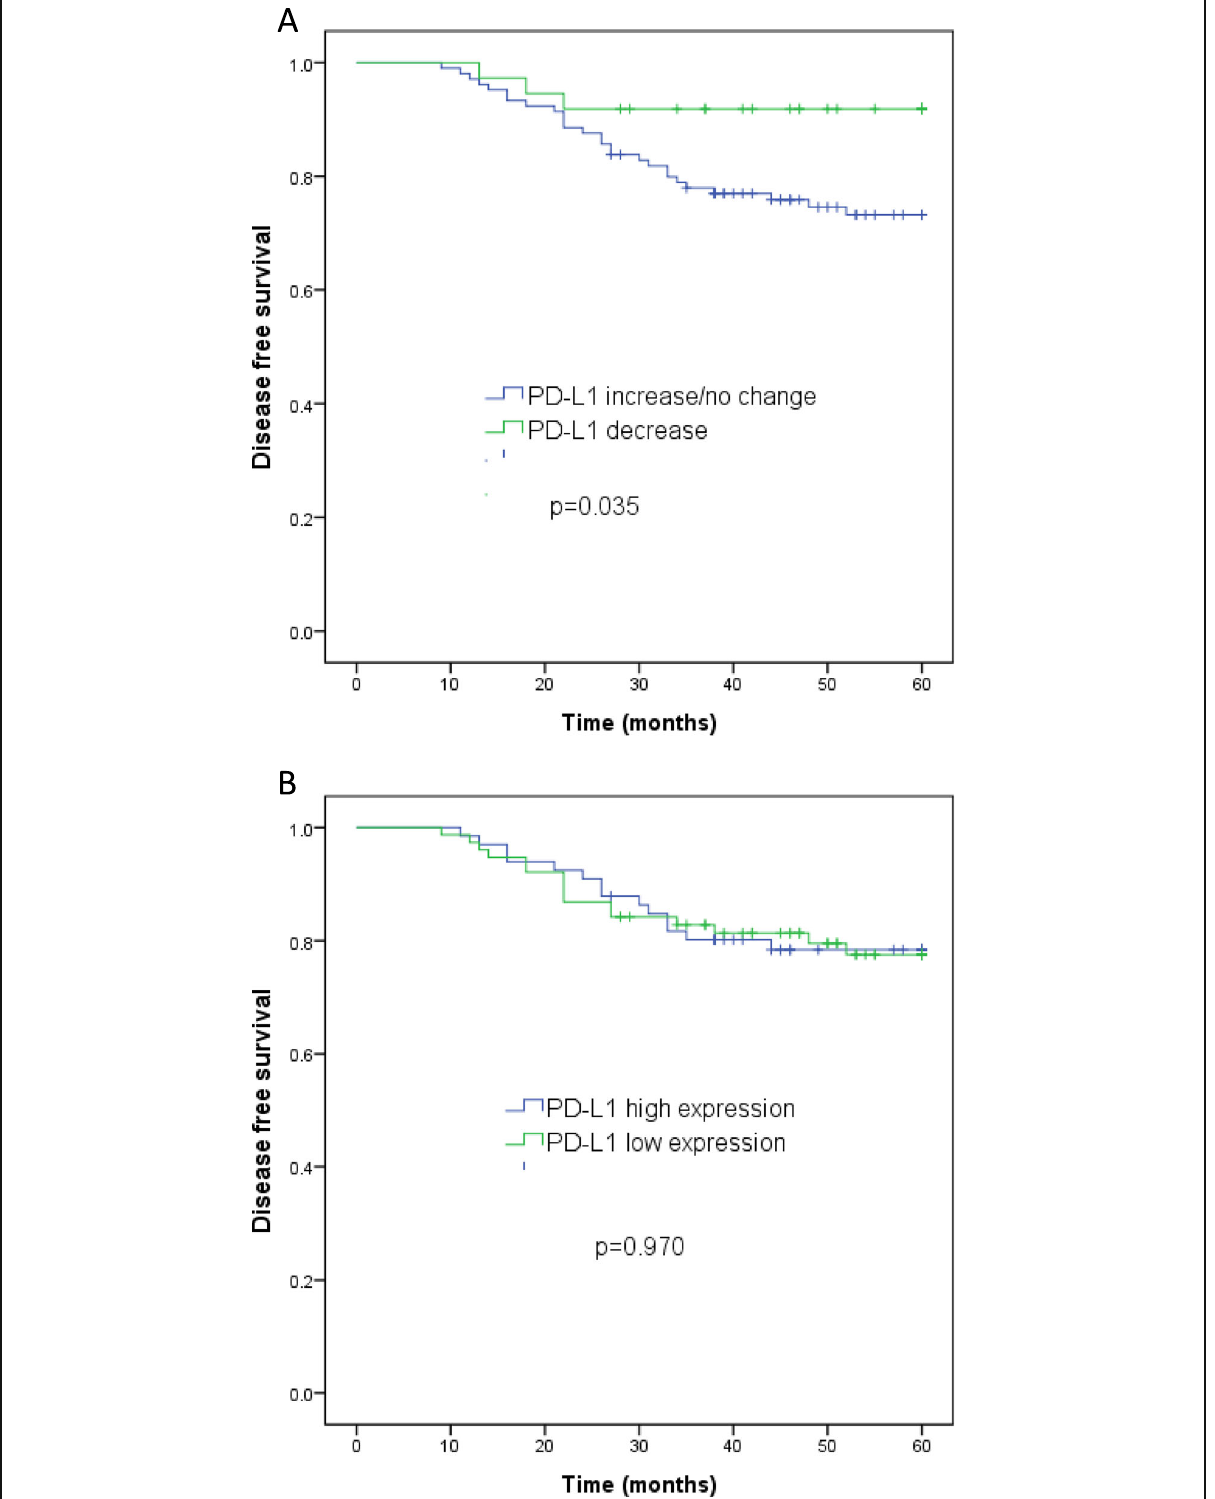
Fig. 4 Survival analysis of cervical cancer patients. Kaplan-Meier curves for disease free survival of cervical cancer patients classified according to PD-L1 change (A) and PD-L1 expression after NAC